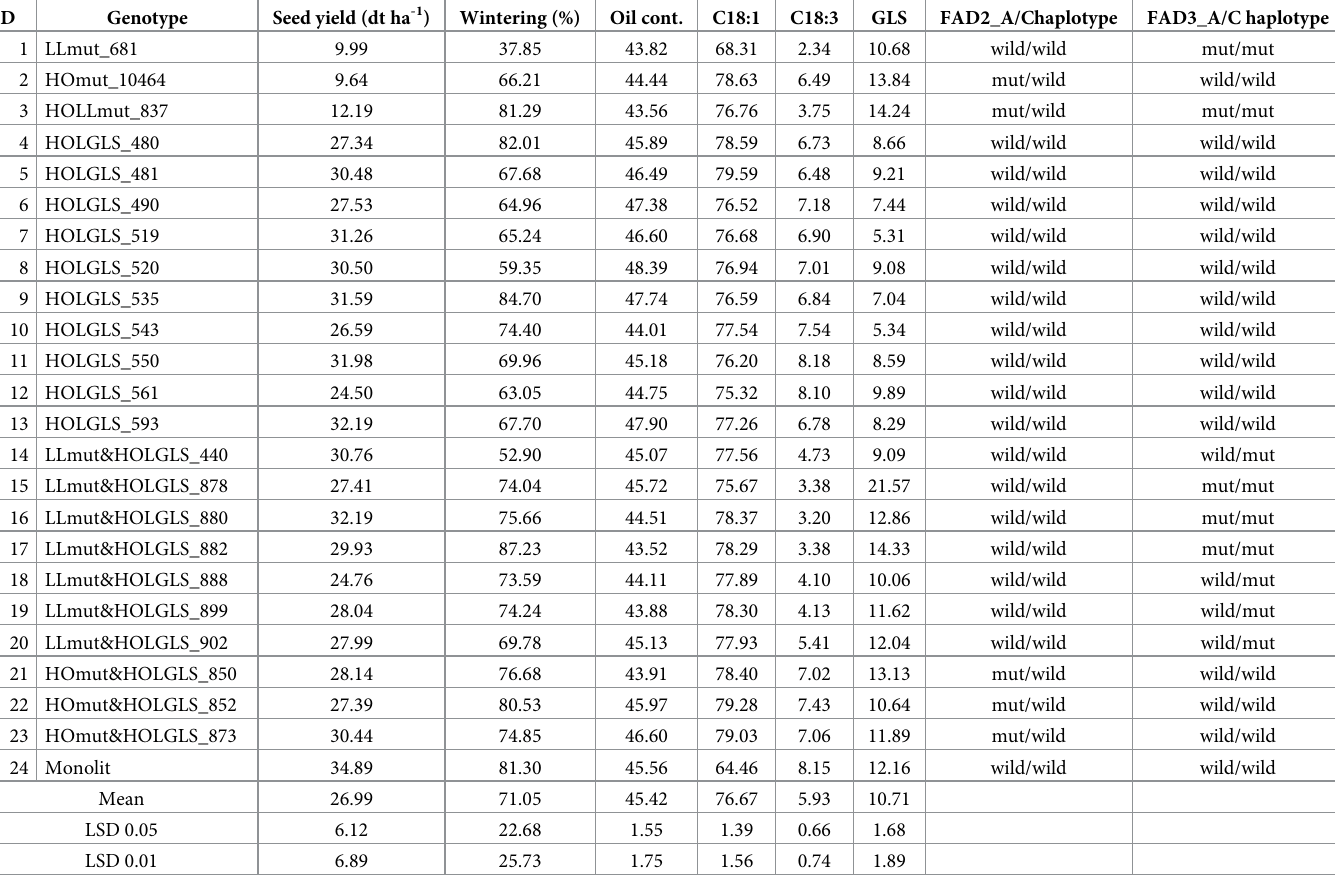
Table 2. Characteristics of the 24 lines tested in field trials conducted in four environments: Mean values of phenotypic traits and allelic variants of FAD2 and FAD3 desaturases in the A and C genomes of B . napus . ID Genotype Seed yield (dt ha -1